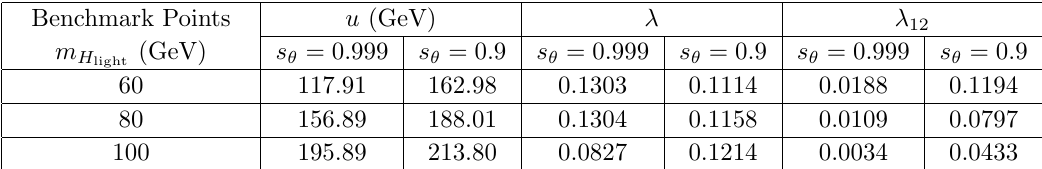
Table 2 . Vacuum Expectation value of singlet scalar ( u ) and the dimensionless couplings in the scalar potential ( (cid:21) 1 = (cid:21) 2 = (cid:21); (cid:21) 12 ) evaluated at some selected benchmark points for m H 80, and 100 GeV with sin (cid:18) = 0 : 999(0 : 90) ; m h